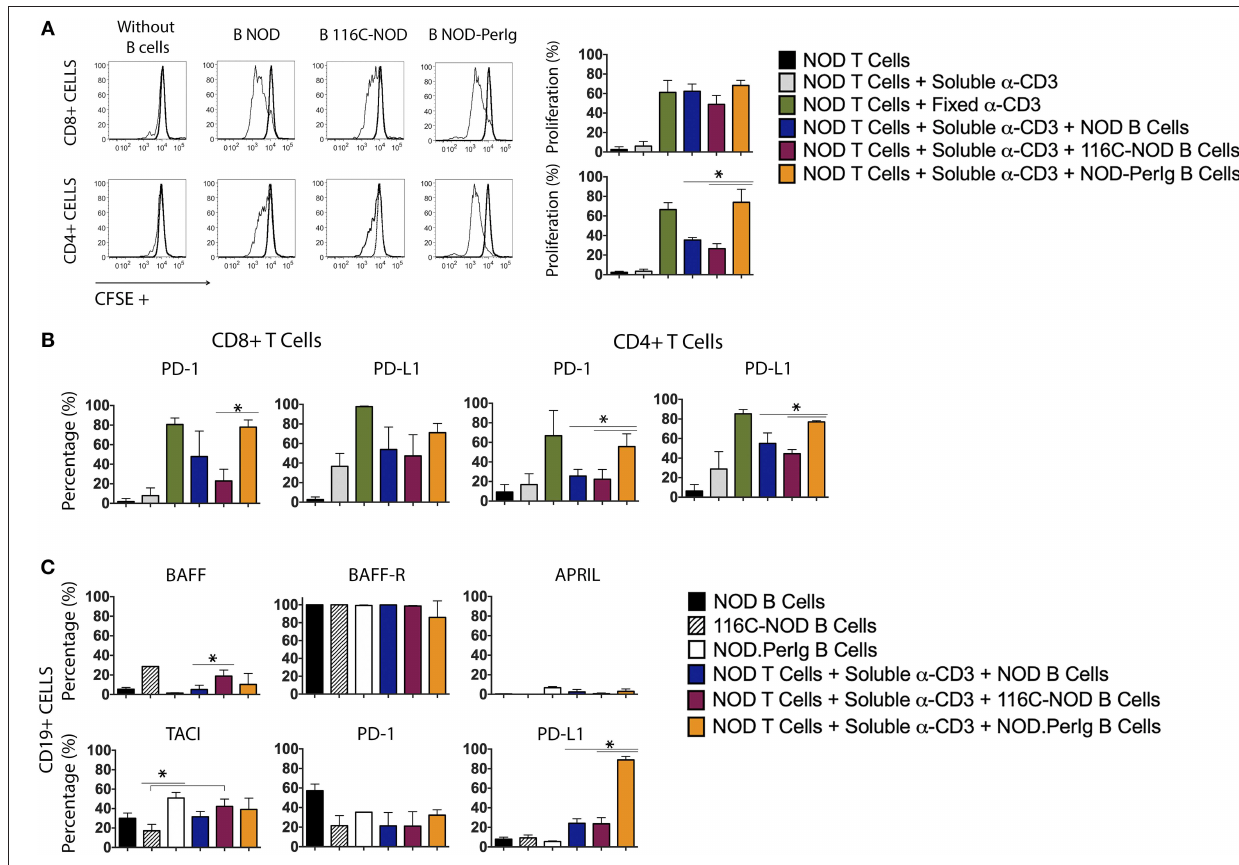
FIGURE 4 | Proliferation assay and molecular marker expression by NOD T-lymphocytes co-cultured with B-lymphocytes from NOD, 116C-NOD, and NOD- PerIg mice. (A) NOD T-lymphocyte proliferation assay. Purified splenic T-lymphocytes from NOD mice were CFSE-labeled and cultured in the presence (narrow line) of soluble anti-CD3, or plate-coated anti-CD3, and either purified NOD, 116C-NOD, or NOD- PerIg B-lymphocytes plus anti-CD3, or without stimulus (bold line) for 72h. Ten NOD mice were used to obtain the T-lymphocyte pool and 4 mice of each group to obtain purified B-lymphocytes. Two replicates were carried out for each experimental condition. The proliferation of CD4 + or CD8 + T-lymphocytes was analyzed independently. (B) The expression of PD-1 and PD-L1 in CD4 + and CD8 + NOD T-lymphocytes was analyzed after co-culturing them as previously described. (C) The proportion of NOD, 116C-NOD, and NOD- PerIg B-lymphocytes expressing BAFF, APRIL, BAFF-R, TACI, PD-1, or PD-L1 was also assessed. All B-lymphocytes were incubated alone without stimulus or in the presence of NOD T-lymphocytes plus anti-CD3 for 72h ( n = 4 per group, with two replicates for each experimental condition). Bars show the SD of the percentage values. Mann-Whitney U, statistically significant differences: * P <